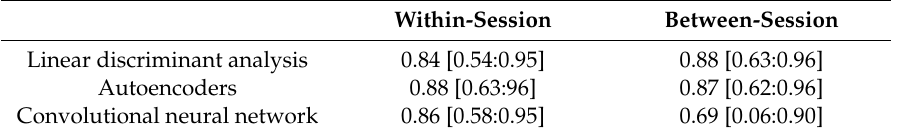
Figure 2. Overall classification accuracy for all motion types. The results are presented as mean ± standard deviation across participants. “Day12” indicates training on data from day 1 and testing on data from day 2. “Day21” indicates training on data from day 2 and testing on data from day 1. LDA (linear discriminant analysis), AE (autoencoders), and CNN (convolutional neural network). Table 2. Intraclass correlation coe ffi cients for the di ff erent calibration scenarios for the three classifiers. The intraclass correlation coe ffi cient and 95% confidence intervals are